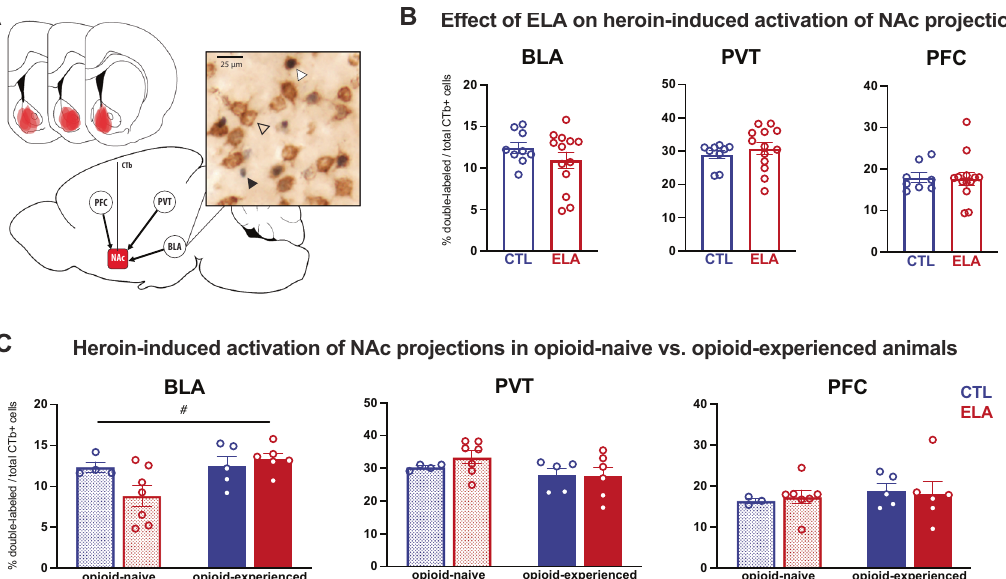
Fig. 6 ELA does not substantially alter the neuronal response to heroin in NAc-projecting cells. A Diagram of NAc CTb injection placements and example of cell appearance. Black arrow = Fos + , clear arrow = CTb + ; white arrow = Fos + CTb + cell. B Percentage of total CTb-labeled cells that are also Fos + in all animals collapsed across opioid exposure conditions. There was no effect of ELA on the activation of NAc-projecting cells in BLA, PVT, or PFC. C Percentage of total CTb-labeled cells that are also Fos + in all animals separated by opioid history. # opioid-naive vs. opioid-experienced P = 0.05. experienced n = 5 CTL/6 ELA; naïve n = 4 CTL (3 CTL for PFC)/7